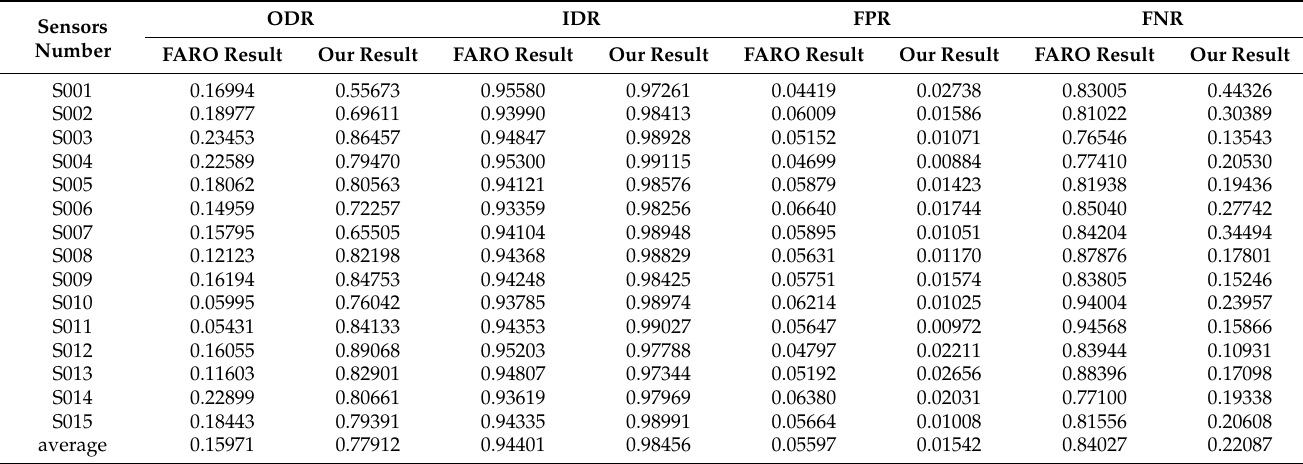
Table 5. Comparison of the quantitative